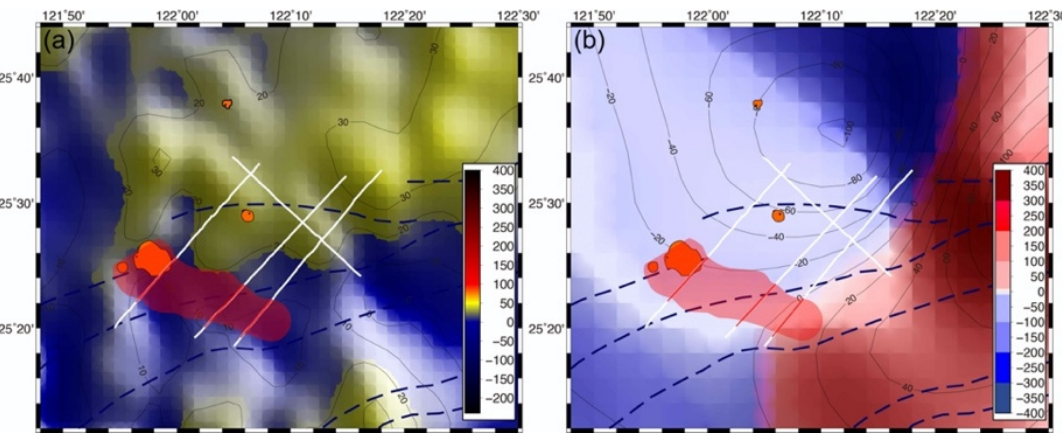
Figure 10. Distributions of potential fields. ( a ) Gravity anomaly and ( b ) magnetic anomaly. Orange and red areas indicate the distribution of the known igneous rocks and lavas observed in this study. Units are in mGal and nT, respectively.